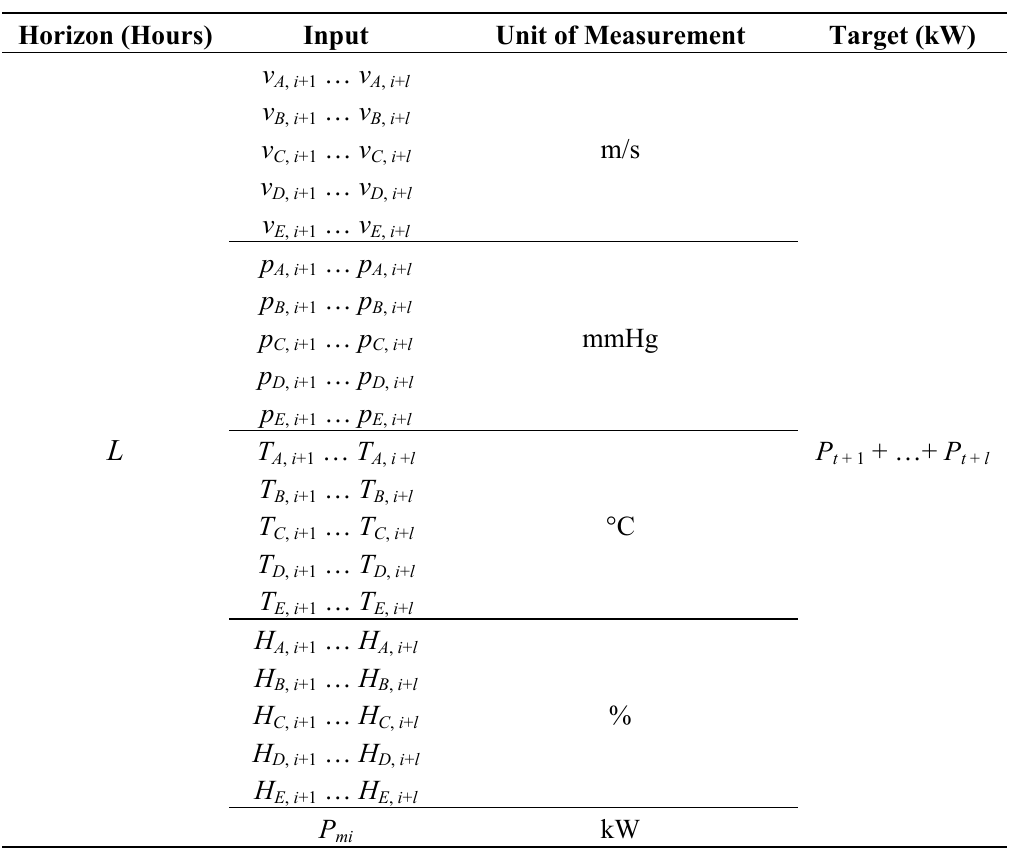
Table 2. Input/target scheme for input vector